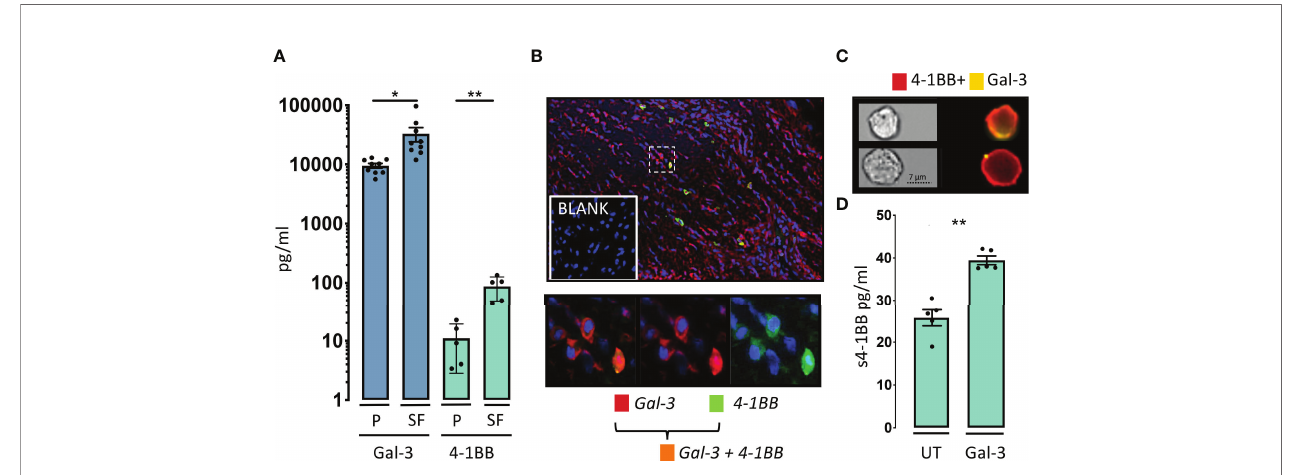
FIGURE 2 | Gal-3 and 4-1BB are increased in the rheumatoid in fl amed microenvironment. (A) In patients with rheumatoid arthritis (RA), soluble levels of Gal-3 (blue, n = 9) and soluble levels of 4-1BB (green, n = 5), were both increased in SF compared with P. Data are expressed as mean ± SEM, Student ’ s paired t-test, *P < 0.05, **P < 0.01, Bars represent mean (SEM). (B) Gal-3 (red) and 4-1BB (cyan) were co-expressed (orange) in the RA synovial membrane often localized to the sublining layer of the membrane (n = 3). Cells were nuclear stained by DAPI (blue), imaged obtained at x40. (C) Co-expression of 4-1BB (red) and Gal-3 (yellow) was also seen in the surface of CD3 and CD28 activated human CD4 T-cells by ImageStream. In the membrane of some 4-1BB+CD4 T-cells Gal-3 were found only in very distinct condense areas in others more diffuse n = 4. (D) Cultured CD4 T-cells were activated by CD3 and CD28 antibodies, with or without, added Gal-3 (400ng/ml), overnight (n = 5). Addition of Gal-3 resulted in a signi fi cantly increase in soluble (s) 4-1BB. Data expressed as mean ± SEM, student ’ s paired t-test, **P<0.01, Bars represent mean